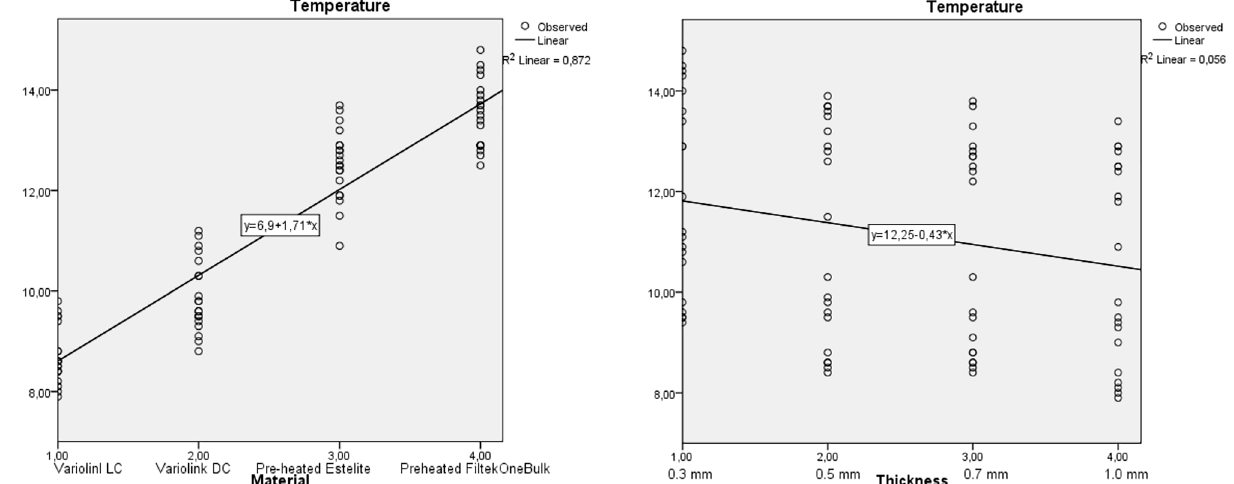
Figure 5. Effect of luting material and ceramic thickness on pulpal temperature change: ( a ) curve fit for material; ( b ) curve fit for